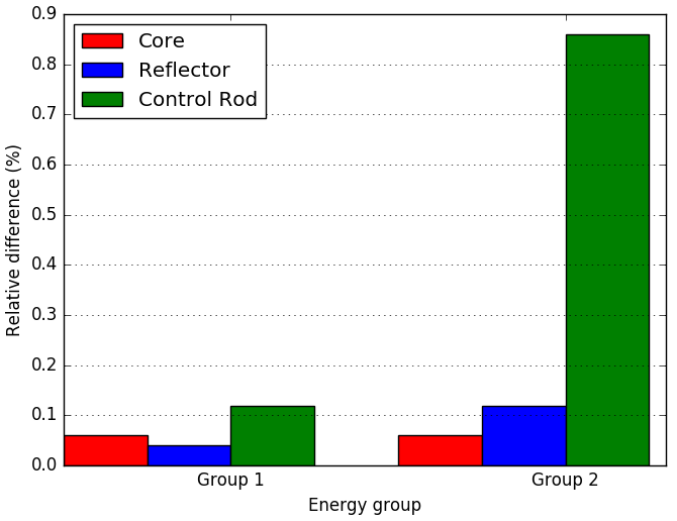
Figure 10. Comparison of region-averaged flux from reference and AZTRAN Model 1 Case 2.